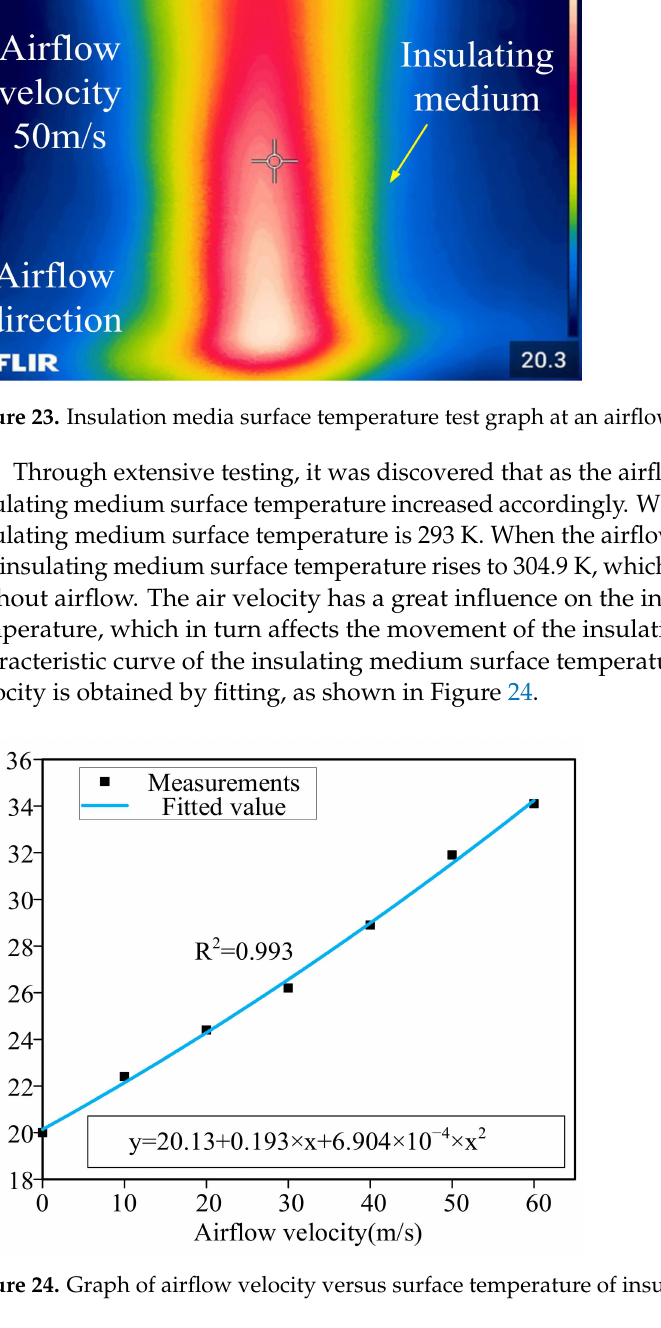
Figure 24. Graph of airflow velocity versus surface temperature of insulating medium. The airflow velocity has a great influence on the insulating medium surface tempera- ture, and the change in the insulating medium surface temperature affects the movement